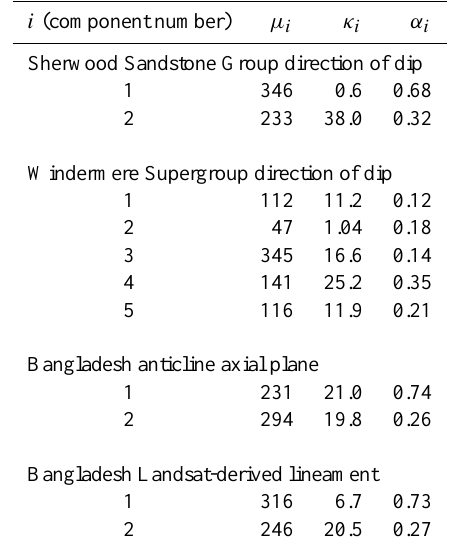
Table 2. Parameters of a fitted mixture of von Mises (MVM) dis- tributions. The i th component occurs with probability α i and has mean µ i and dispersion parameter κ i . Values for direction of dip are degrees clockwise from north, and values for the Bangladesh anticline axial planes and Landsat-derived lineaments are doubled orientation